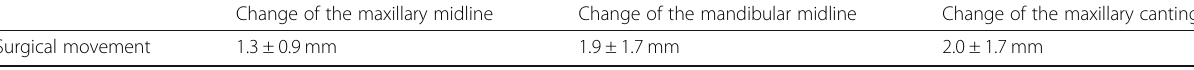
Table 1 Surgical changes measured in P-A cephalograms 1 month before and 6 months after surgery Change of the maxillary midline Change of the mandibular midline Change of the maxillary canting Surgical